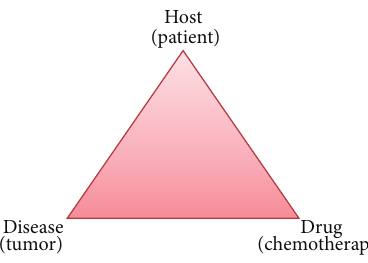
Figure 3: “Therapeutic triad” of the host, the drug, and the disease: factors to consider when giving chemotherapy to